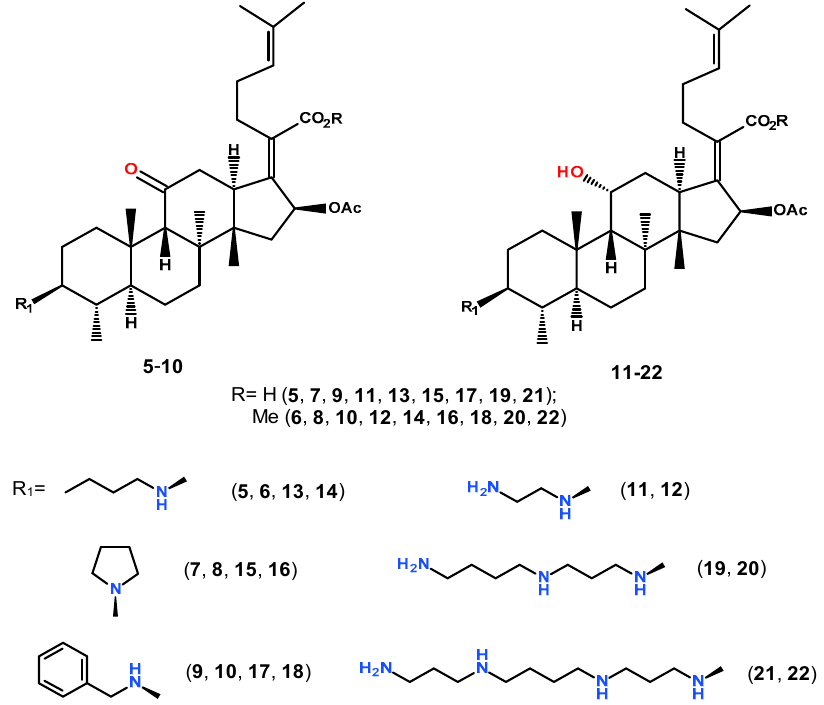
Figure 1. Structures of 11-oxo-3 β amino and 11 α -hydroxy-3 β amino derivatives of fusidane triterpe- noids.